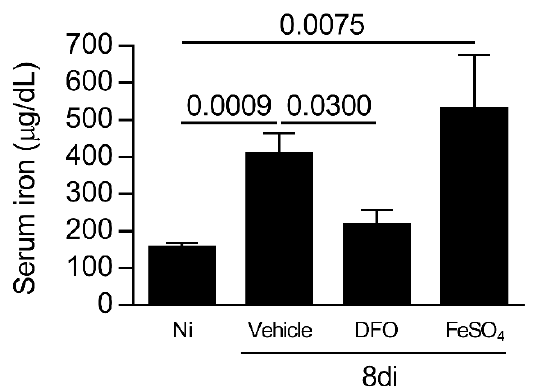
Figure 3. Iron levels in the sera of C57BL / 6 T. gondii -infected mice treated with an iron chelator or iron supplemented. Iron serum levels of C57BL / 6 mice non-infected (Ni) or infected with 20 cysts of ME-49 strain of T. gondii by the oral route and treated with vehicle (PBS, phosphate bu ff ered saline) or 300 mg / kg deferoxamine (DFO) or 100 mg / kg of ferrous sulfate heptahydrate (FeSO 4 ) intraperitoneally (i.p.) one day before infection and for an additional seven days post-infection. Data were analyzed by Kruskal Wallis followed by Dunn’s post-test.